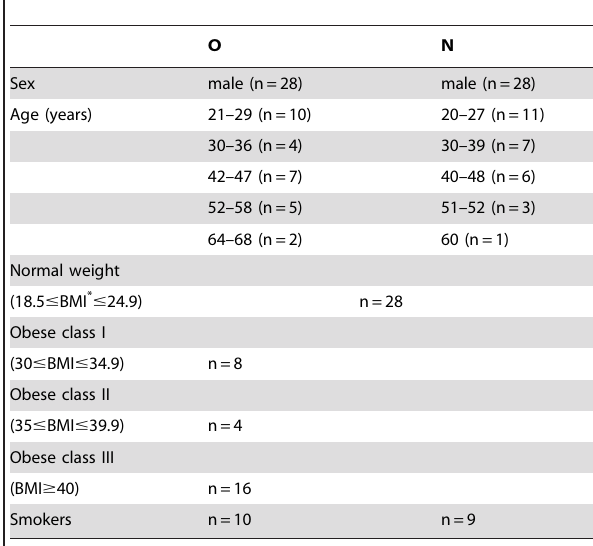
Table 1. Description of saliva